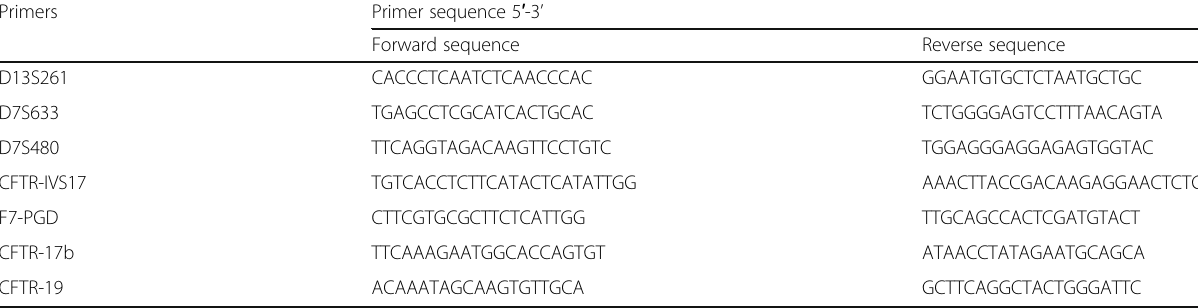
Table 1 Primer sets for mutation detection and linkage analysis Primers Primer sequence 5 ′ -3 ’